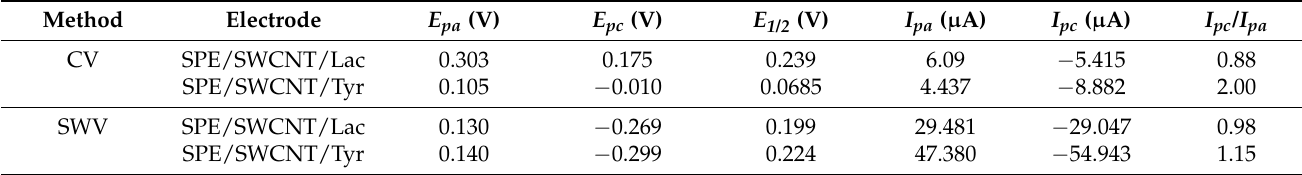
Table 1. The values of the parameters obtained from the cyclic voltammograms and square